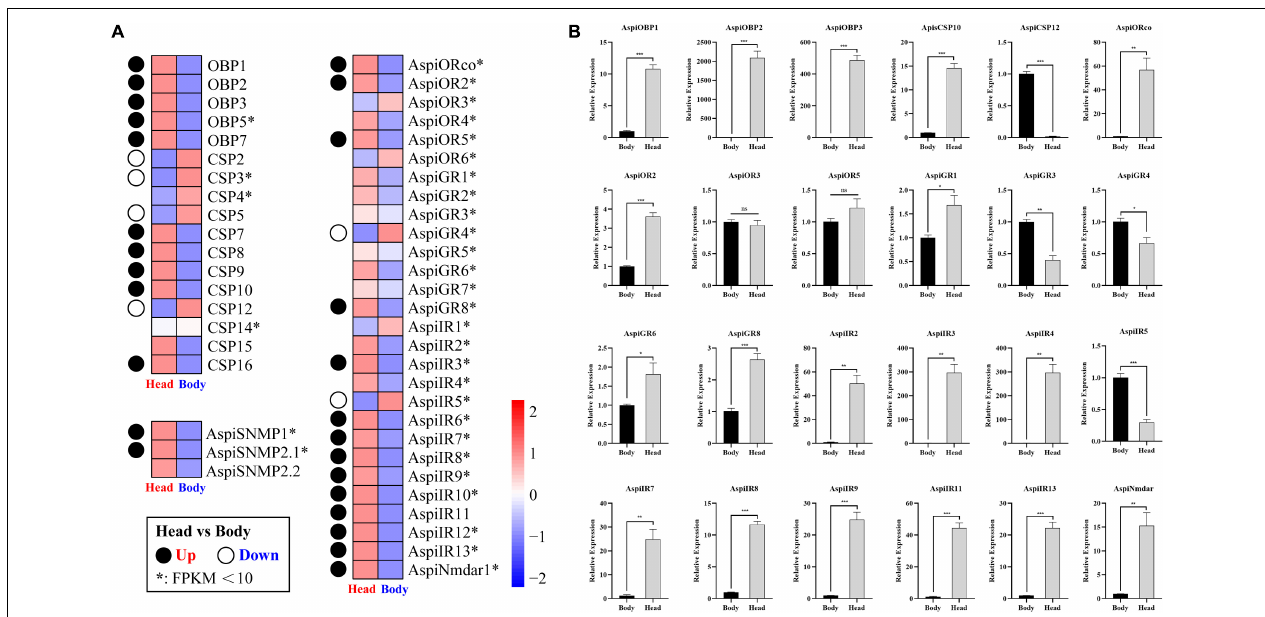
FIGURE 9 | Expression profiles of chemosensory genes in different tissues. (A) Heatmap of chemosensory genes in the antennal transcriptome. Significance means an absolute value of log 2 Ratio ≥ 1 and FDR < 0.05. (B) Validation of selected chemosensory genes in different tissues by qPCR.